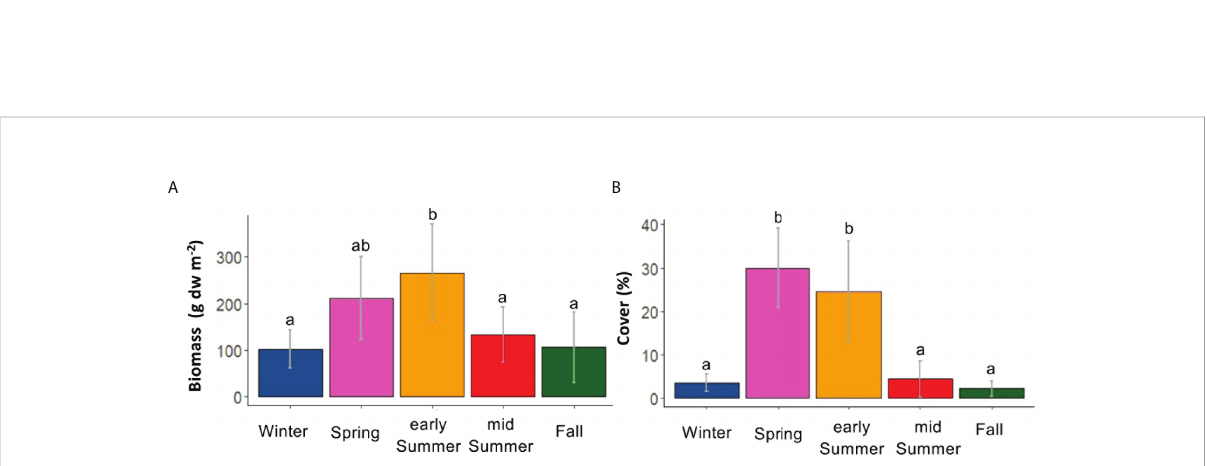
FIGURE 2 Barplots of the seasonal variability in terms of (A) biomass (g dw m -2 ± SD) and (B) cover (% ± SD) of Gongolaria rayssiae. Letters represent statistical differences between the seasons.